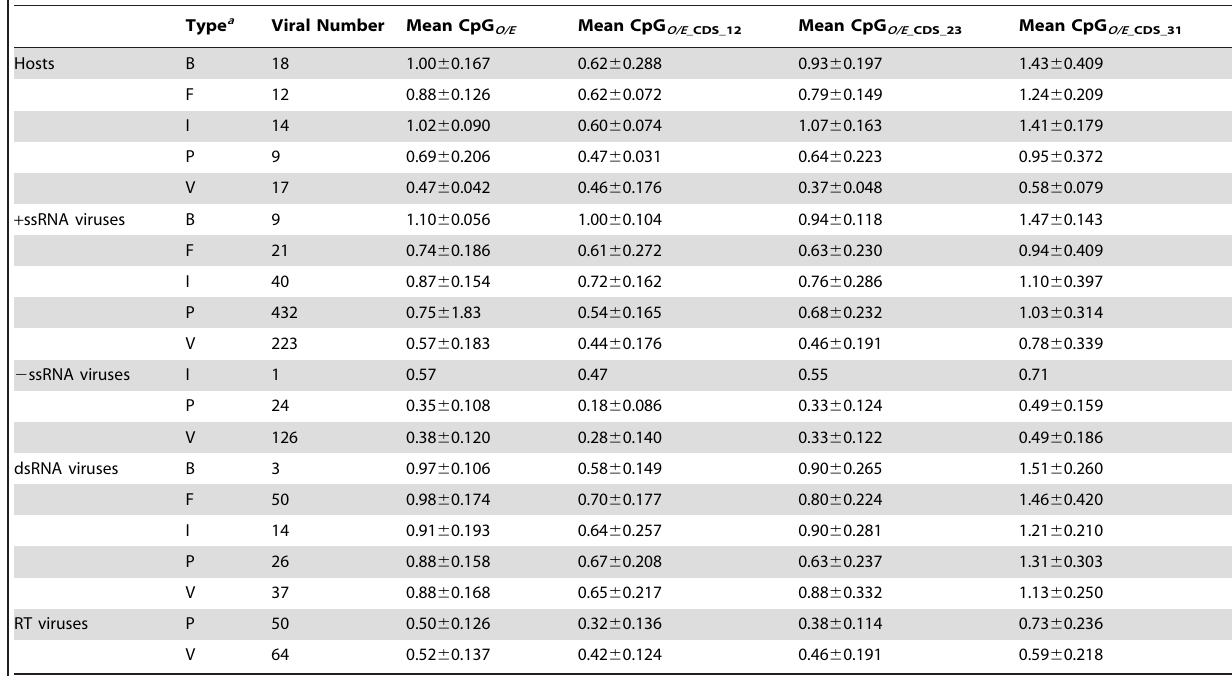
Table 3. CpG usage of RNA viruses and their respective